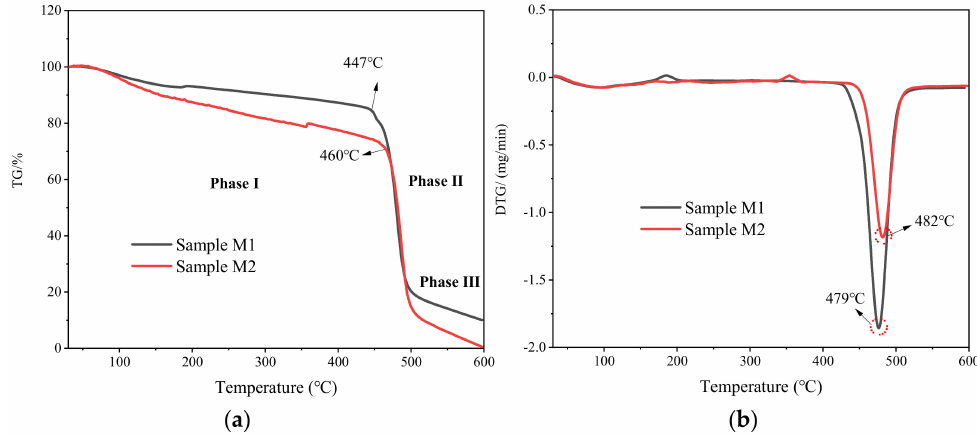
Figure 7. TG and DTG curves of ( a ) PVDF nanofiber membrane-M1 and ( b ) PVDF/SDS nanofiber